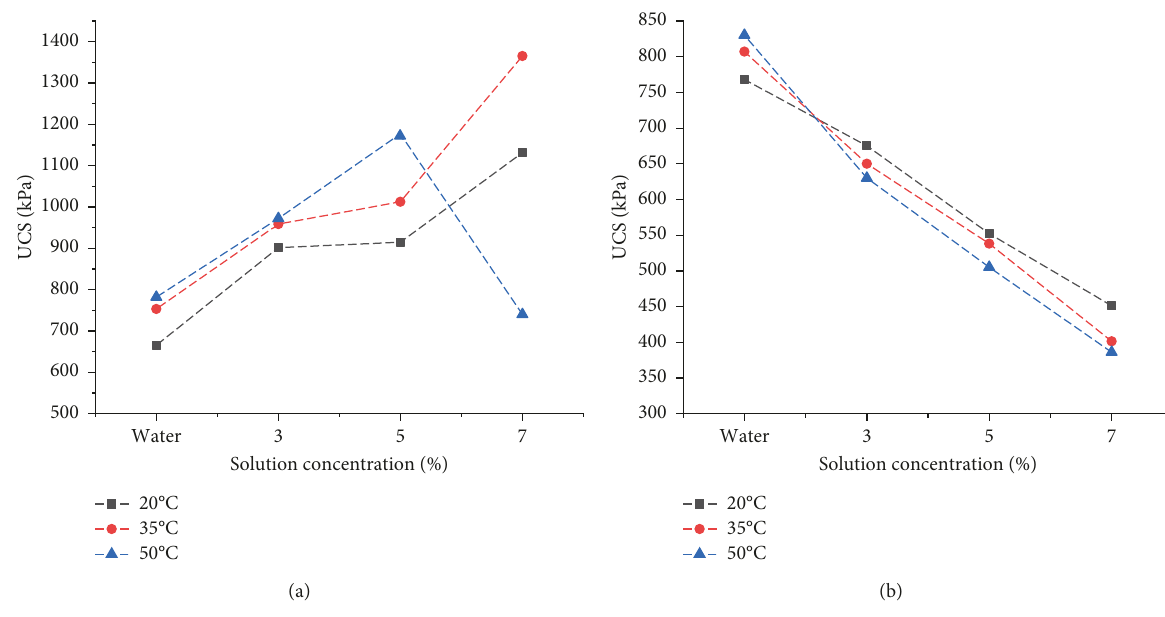
Figure 3: Change in UCS of CPB. (a) 7d and (b)